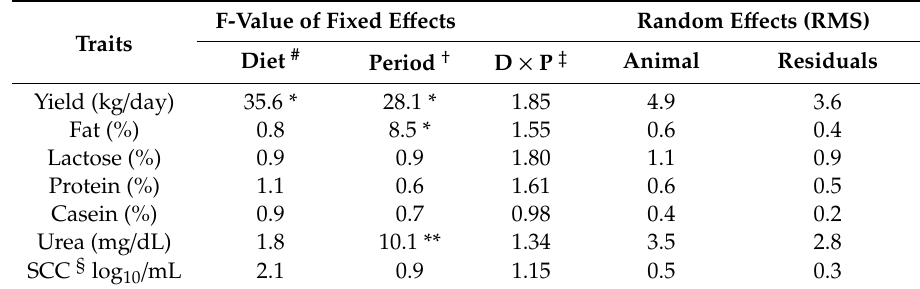
Table 4. Results of the milk yield and quality traits from ANOVA (F-value and significance) for fixed e ff ects (diet, period and their interaction) and RMS for random e ff ects (animal and residuals). F-Value of Fixed E ff Traits